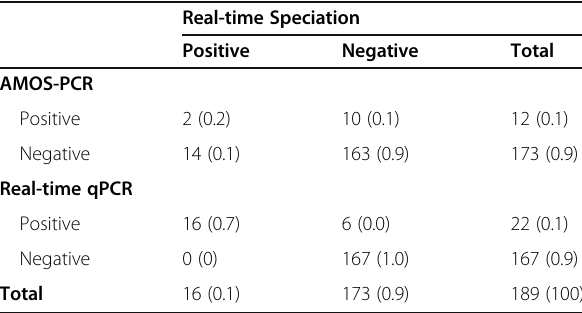
Table 3 Cross tabulation of the molecular tests used, with real- time qPCR speciation assay as the